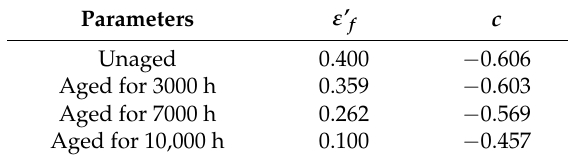
Table 2. Coffin–Manson parameters of materials at different aging states.